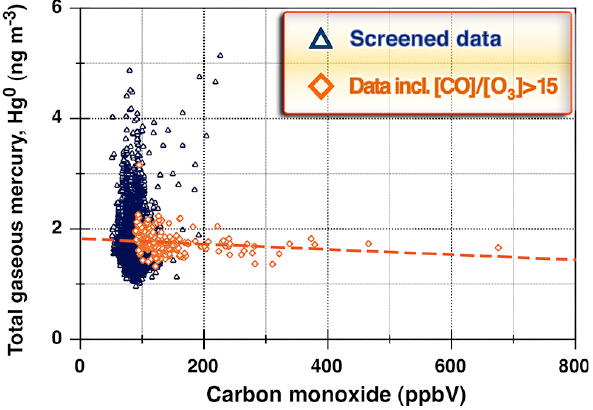
Figure 8 . The relationship between TGM, Hg 0 and CO during events of pollution from the ship’s internal engine determined by a ratio of [CO]/[O 3 ] larger than 15 (diamonds). Also included are the data screened according to Chapter 3.1.1 (triangles) but not comprised in the linear regression fit. The parameters are only weakly correlated implying that the ship's emissions are negligible with respect to Hg.